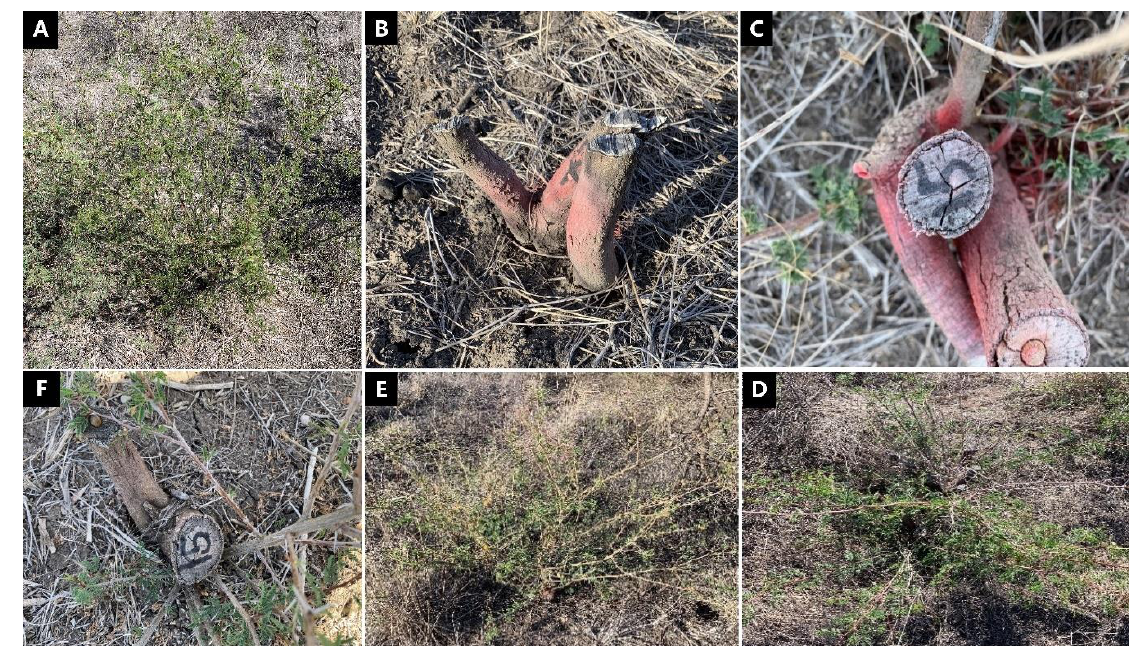
Figure 7. Cut stump regrowth (stem sprouts per plant) of mimosa bush 3, 8 and 15 MAT following cut stump herbicide application in trial 3. H, hexazinone; G, glyphosate; C, clopyralid; AM, aminopyralid + metsulfuron-methyl; TyP_diesel, triclopyr + picloram mixed with diesel. For each monitoring time, columns with different letters indicate significant dif- ference by Tukey’s test with 95% confidence.